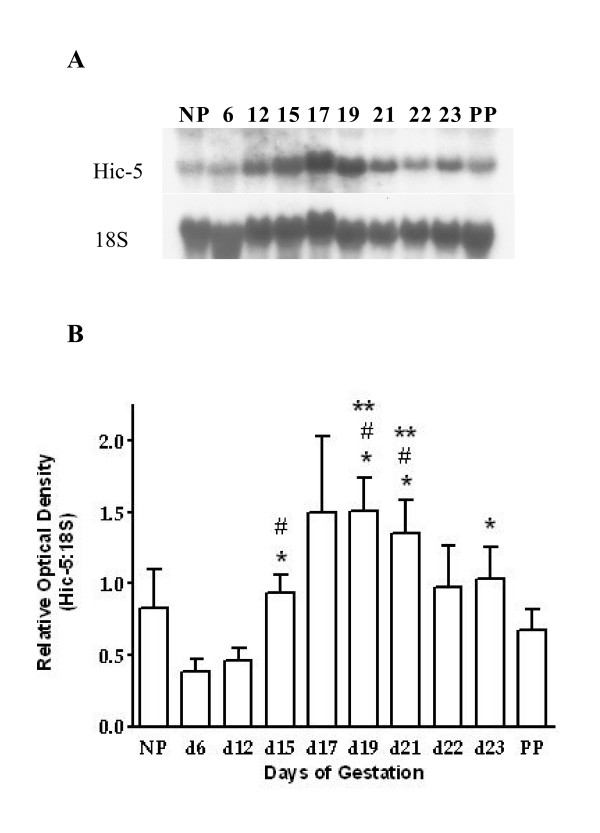
Northern blot analysis of Hic-5mRNA expression in rat myometrium during pregnancy, labour and 1 day postpartum. (A) Representative Northern blots of Hic-5 mRNA expression and 18S rRNA expression. Analysis was performed with a Hic-5-specific mouse cDNA and an 18S ribosomal rRNA-specific rabbit cDNA as templates for radiolabelled probe production. (B) Densitometric analysis illustrating the increase of Hic-5 mRNA expression during late pregnancy. Hic-5 mRNA expression on d15, d19, d21, and d23 (active labour) was significantly elevated compared to d6 (p < 0.05; *) and expression on d15, d19, and d21 was significantly elevated compared to d12 (p < 0.05; #). Furthermore, Hic-5 mRNA expression was significantly elevated on d19 and d21 (p < 0.05; **) compared to PP. Values are from 4 independent experiments (n = 4) ± SE. Days 6, 12, 15, 17, 19, 21, 22 and 23 represent gestational timepoints. NP = non-pregnant, PP = 1 day postpartum.